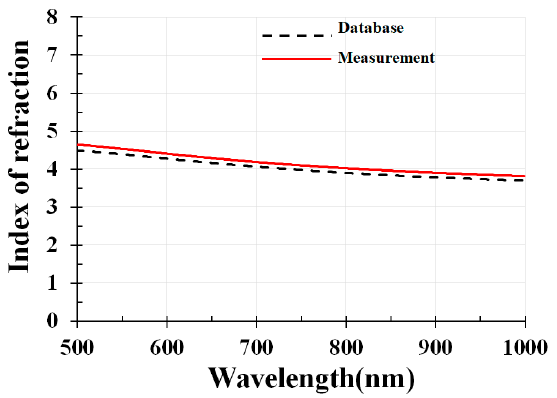
Figure A3. The indexes of refraction of a-Si versus wavelength from measurement and database.